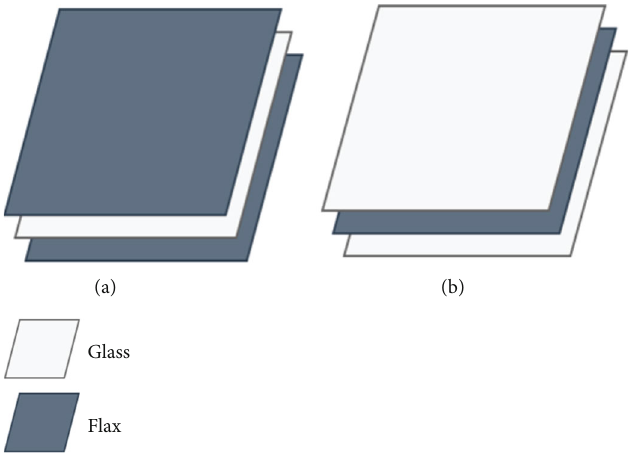
Figure 2: Fabric stacking sequence of composite laminates: (a) H1 hybrid and (b) H2 hybrid.